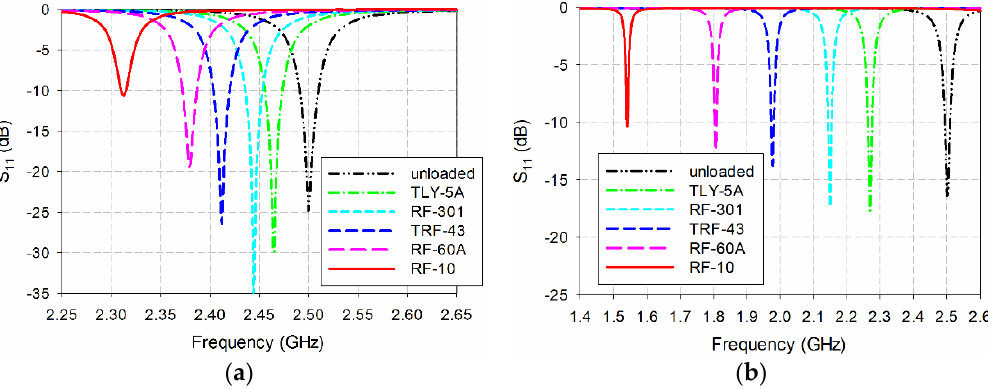
Figure 12. Simulated S 11 characteristics of ( a ) the first resonant frequency of the conventional MPSA and ( b ) the second resonant frequency of the proposed scaled DR-CSRR-RA DGS-loaded MPSAs for the MUTs in Table 2.